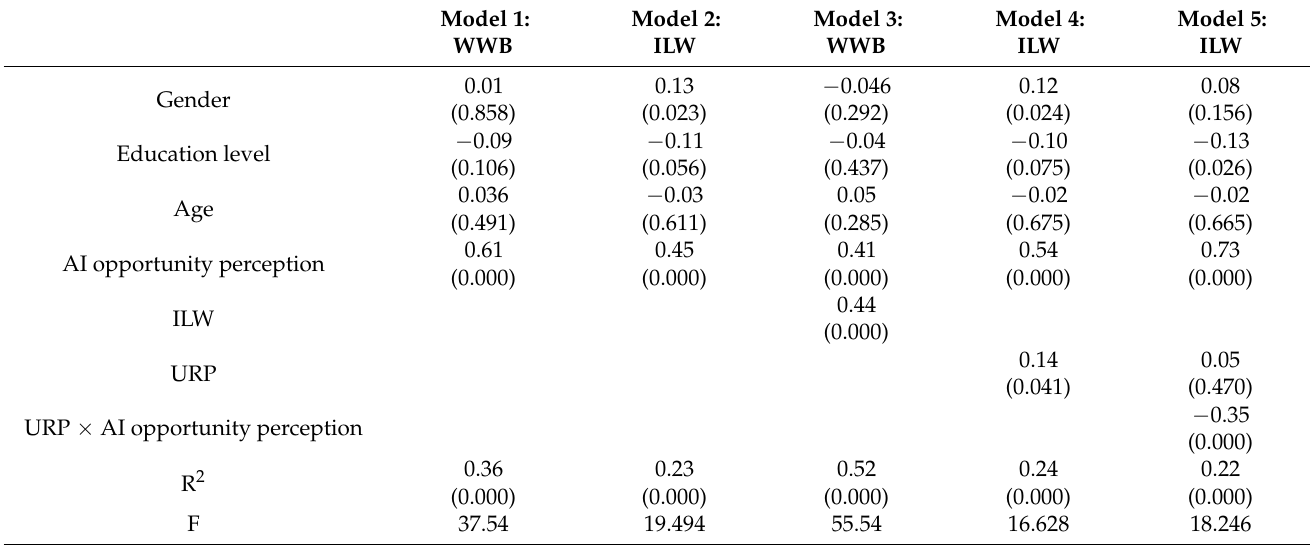
Table 4. Hierarchical regression analysis results of